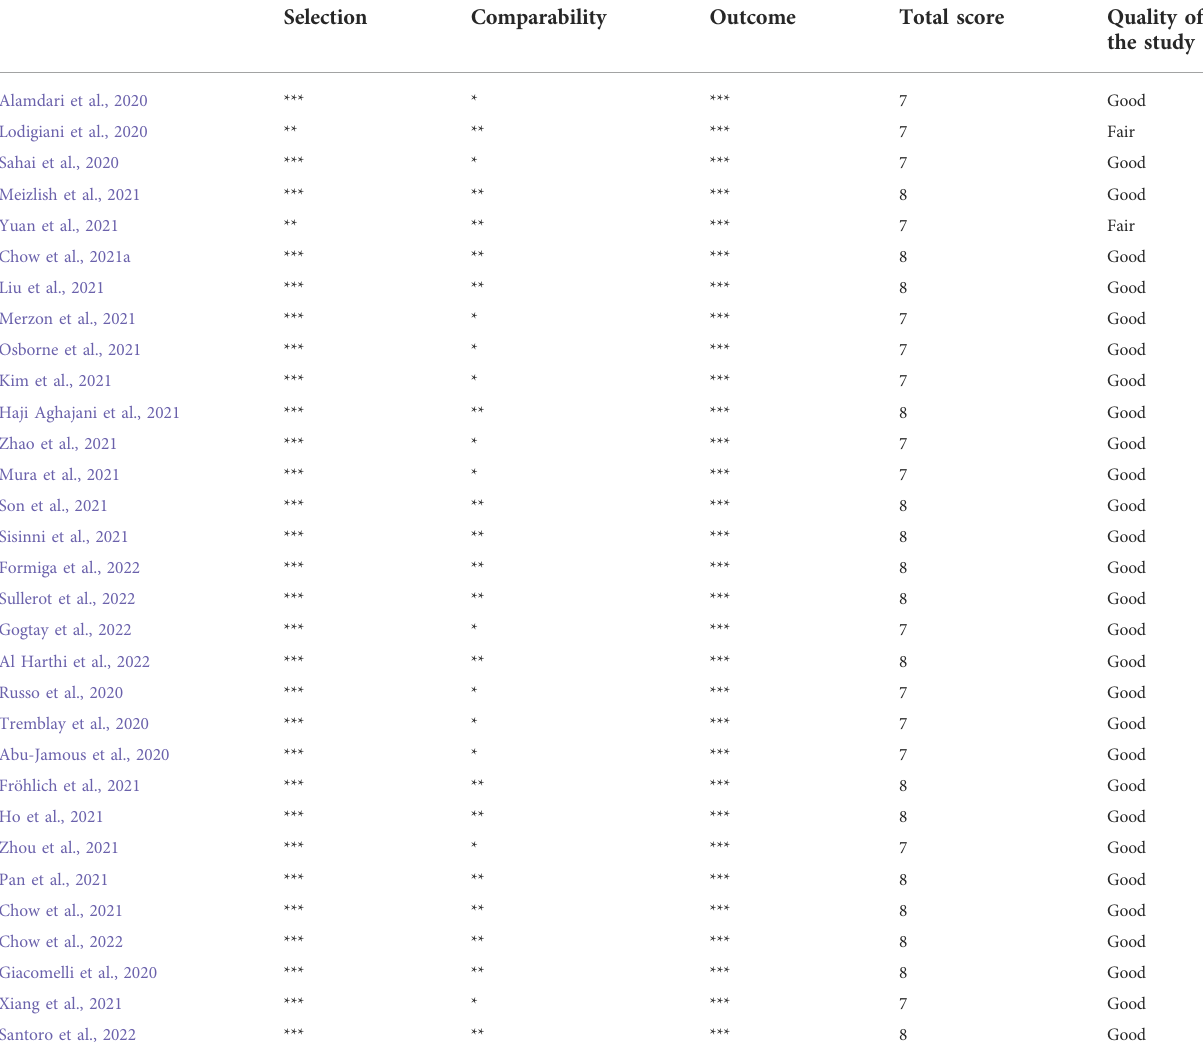
TABLE 1 The qualities of retrospective and prospective cohort studies assessed by the Newcastle-Ottawa scale.